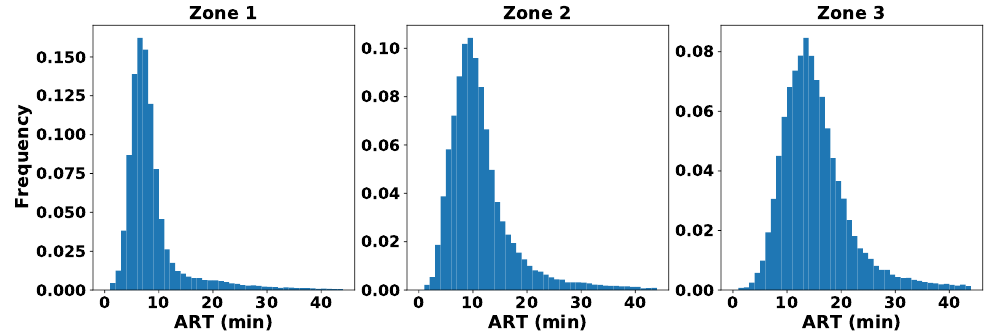
Figure 1. Distribution of the ART variable for zones Z1, Z2, and Z3,